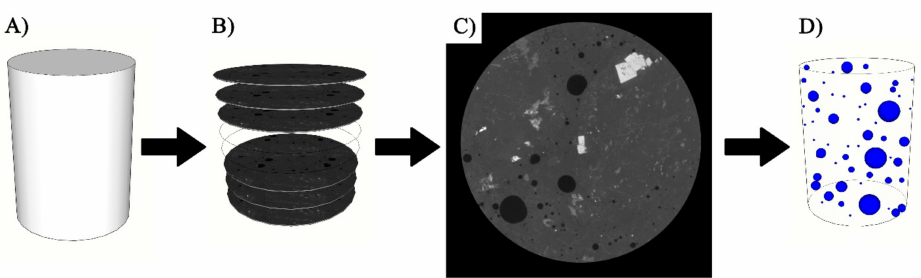
Figure 5. Approach 2: Threshold method of entire stack (3D). ( A ) Extracted core from larger beam, ( B ) Entire image stack, ( C ) A sample of reconstructed image, and ( D ) cylinder prism as final